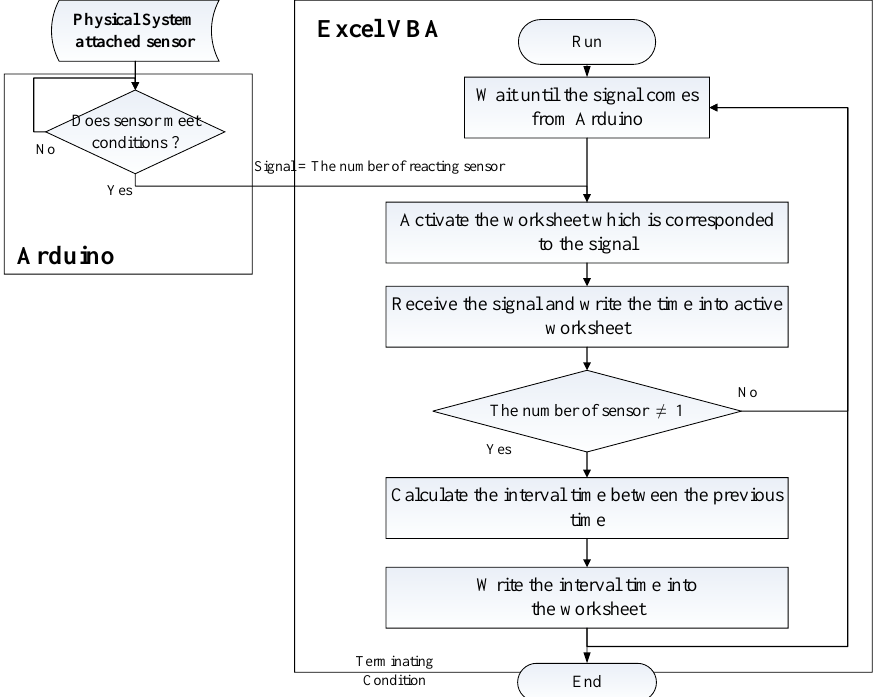
Figure 8. Flow of processing logic of the Excel VBA program.